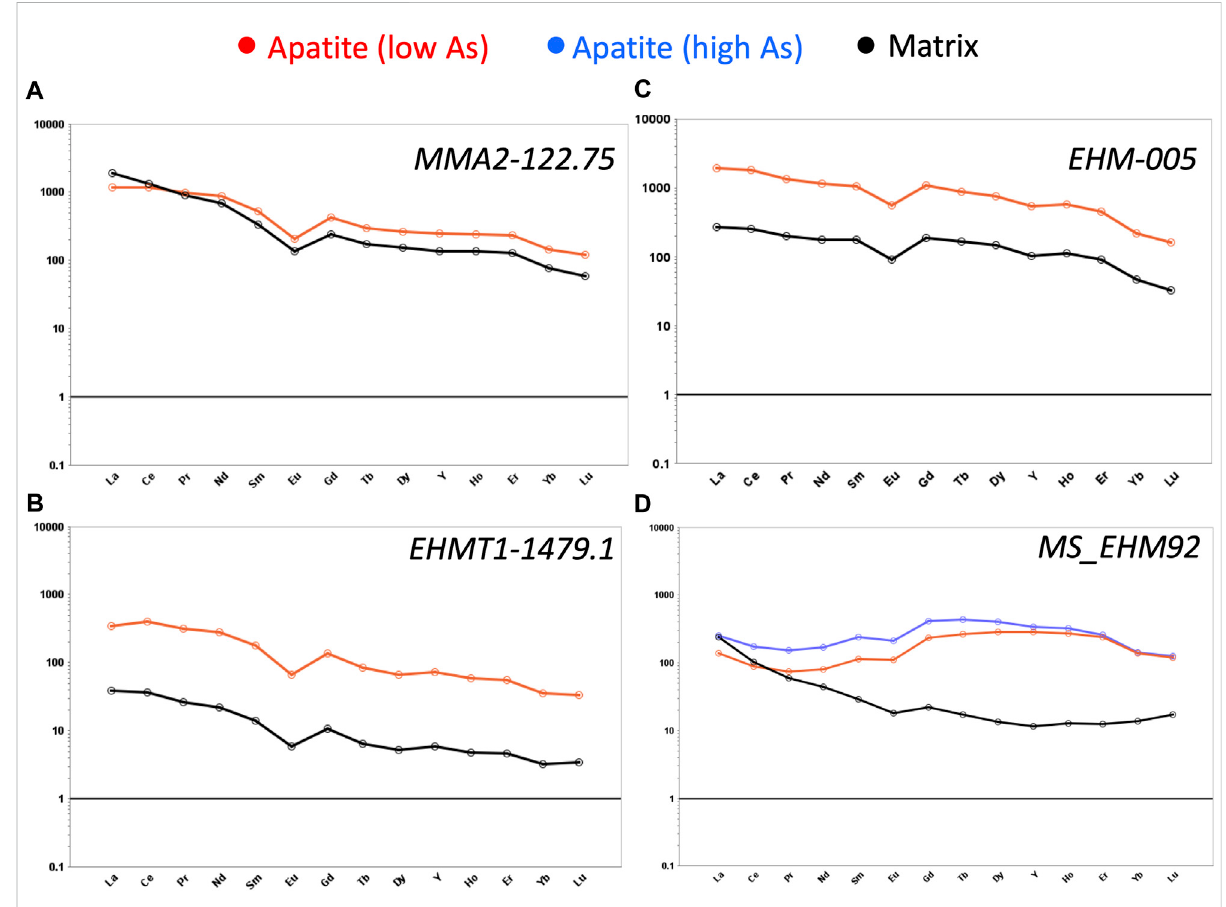
FIGURE 10 Rare earth element (REE) spider plots, normalized to chondrite (Sun and McDonough, 1995). (A) MMA2-122.75. (B) EHMT1-1479.1. (C) EHM- 005. (D) MS_EHM92.